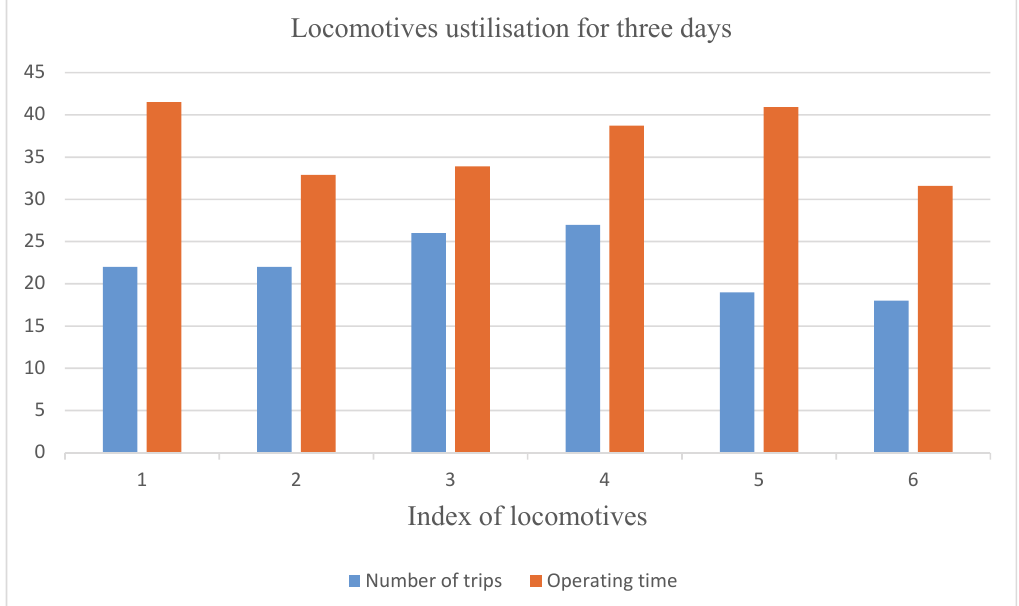
Fig. 14. Operating time for the three days schedule using 6 locomotives